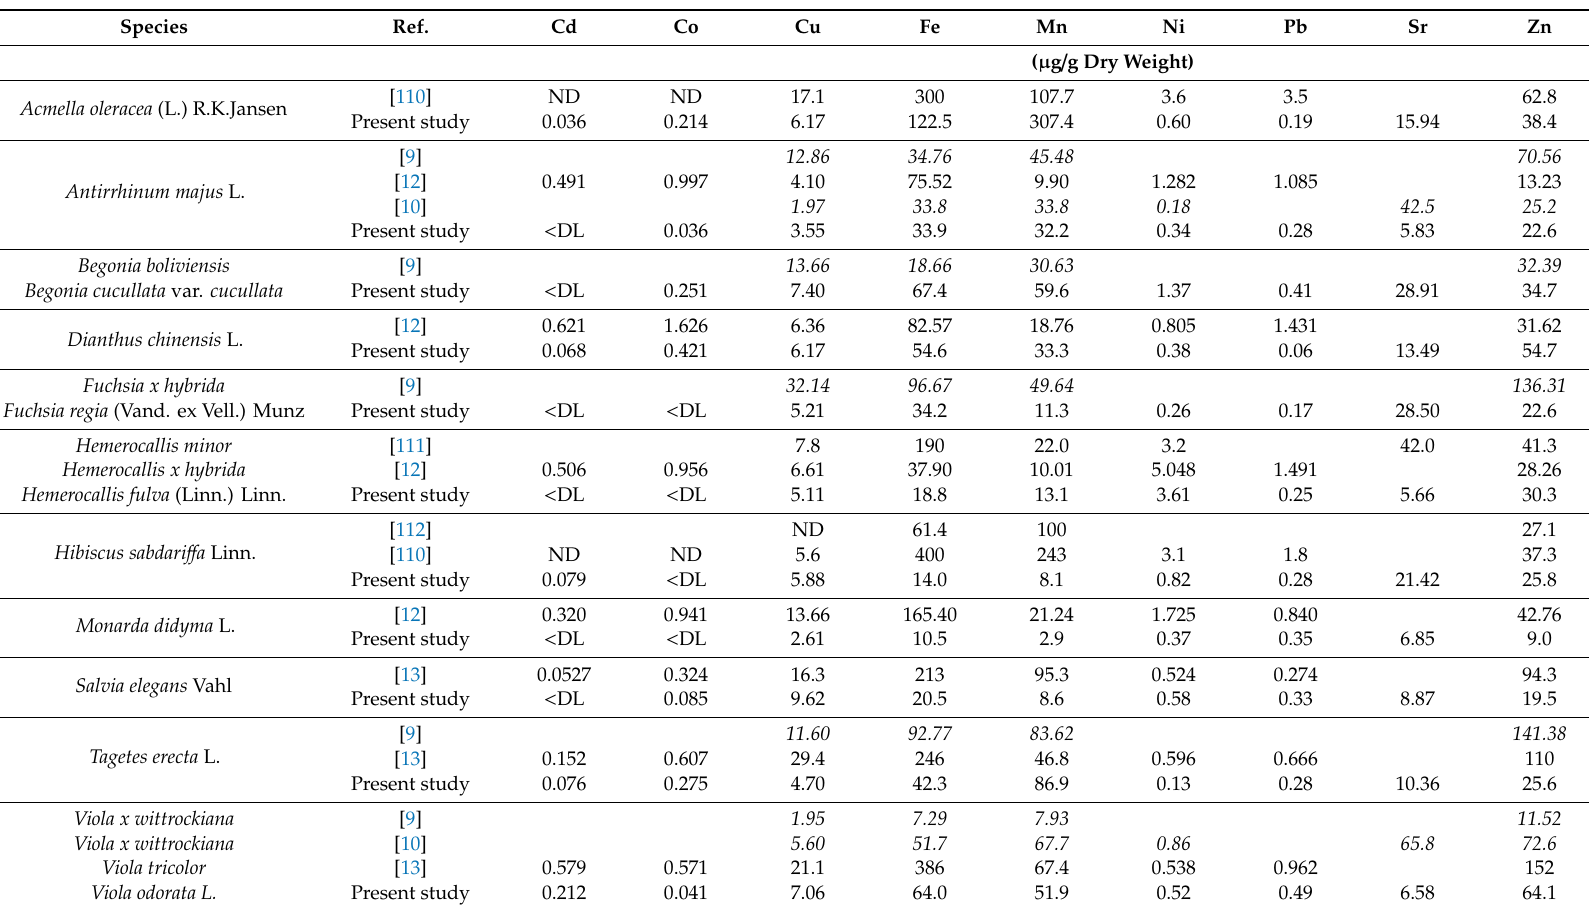
Table 2. Comparison between the trace element concentrations (average values, as µ g / g dry weight) reported in literature and the data of the present study for the same (or similar) floral species. The concentrations expressed on fresh weight basis in the cited literature were converted to dry weight basis (italic). Species Ref. Cd